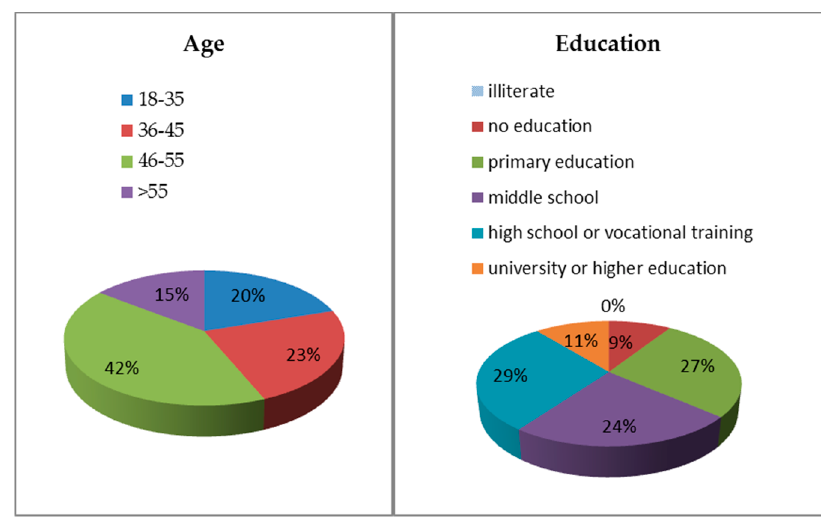
Figure 2. Personal attributes of the farmers.